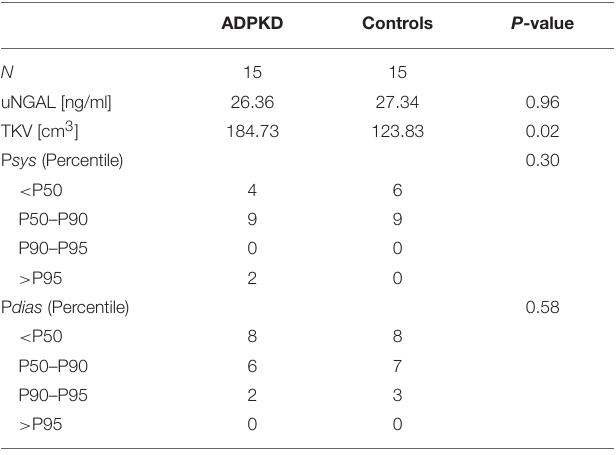
TABLE 3 | Urinary NGAL, Total Kidney Volume and arterial pressure in percentile between groups. ADPKD Controls P